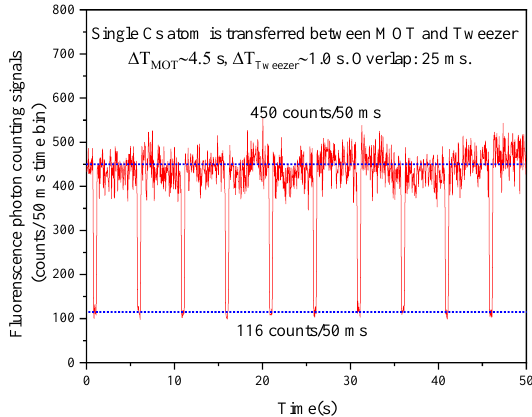
Figure 6. Atomic transfer signal between the MOT and the optical tweezer. The period is 5.5 s, in which the MOT duration is 4.5 s and the optical tweezer last for 1.0 s. The MOT overlaps with the optical tweezer for 25 ms, and the single-atom is transferred between the MOT and the optical tweezer.